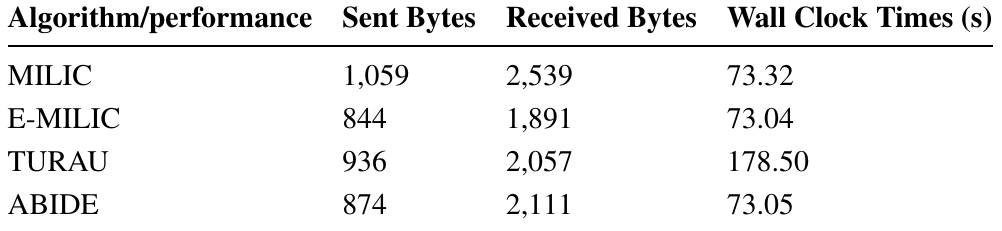
Table 5. Performance of algorithms in caterpillar-like topology.